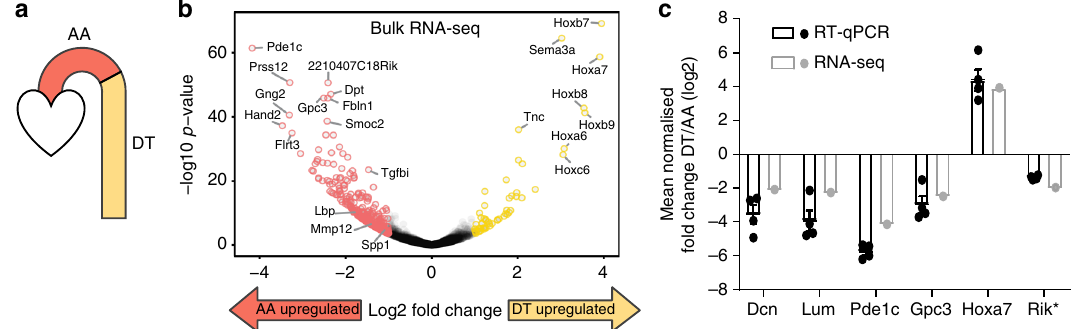
Fig. 2 Bulk RNA-seq of VSMCs from the aortic arch and descending thoracic aorta. a Schematic representation of the aorta, indicating the aortic arch (AA) and descending thoracic aorta (DT). b Volcano plot showing signi fi cance (-log 10 p -value) versus relative gene expression in VSMCs from the DT versus the AA. Genes showing signi fi cant differences in expression (adjusted p -value < 0.01, log 2 fold change > 1) are labelled in yellow (upregulated in DT) and red (upregulated in AA). Gene names for selected genes are indicated. Three independent samples were analysed for each region (AA and DT samples paired). c Relative expression (log 2 (DT/AA)) of selected genes determined by RT-qPCR (black dots/bars, n = 4) and bulk RNA-seq (grey dots/bars). Error bars indicate s.e.m. from four independent RT-qPCR experiments. Rik*: 3632451O06Rik